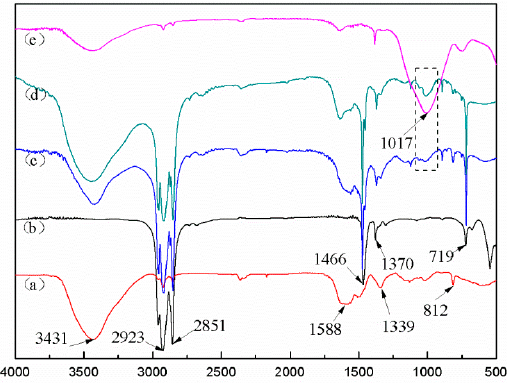
Figure 3. Fourier transform infrared (FTIR) spectra of C18 and phase-change microcapsules (microPCMs): (a) Melamine-urea-formaldehyde (MUF) shell, (b) C18, (c) S0, (d) S4, and (e) diatomite.